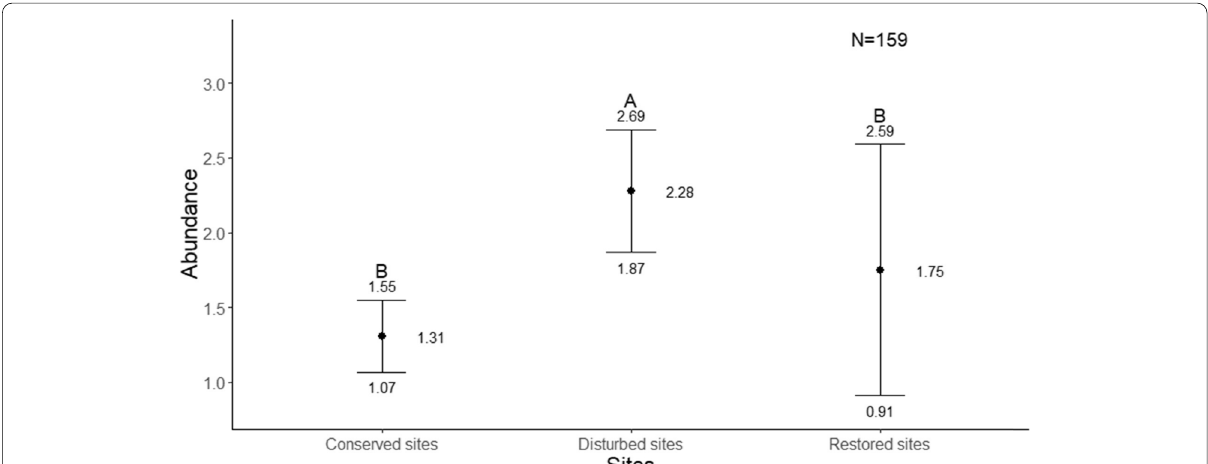
Fig. 4 Pairwise comparison of arthropod abundance in conserved, restored, and restored sites in the PSAER, based on 857 arthropods in total. Conserved, restored, and disturbed sites were grouped respectively to facilitate the interpretation with ANOSIM differences, which are based in Bray–Curtis distances. The points represent the real mean abundance obtained in our sampling, which is to the right of the bar. Maximum and minimum were calculated through standard error. Different letters represent different groups